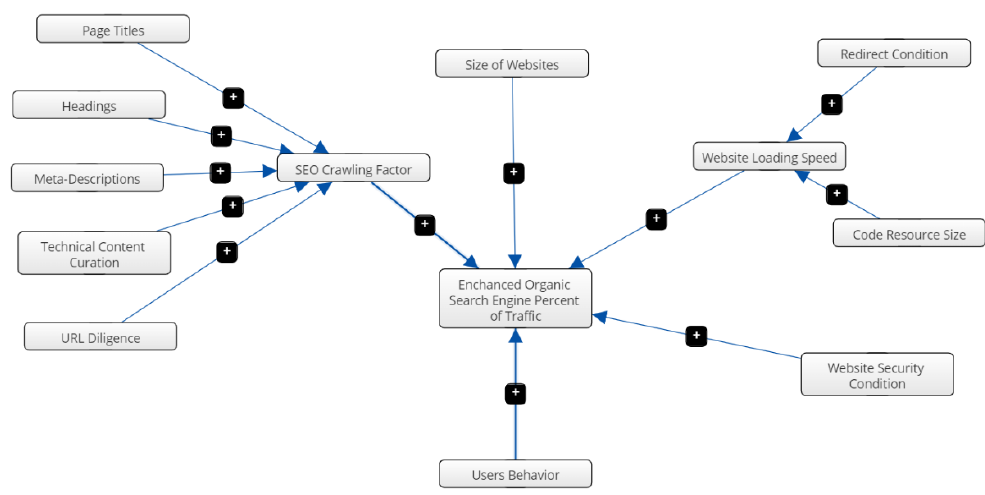
Figure 7. Fuzzy Cognitive Mapping integration as a descriptive, aggregated, and macro-level modeling method for representing the impacts among the examined factors on the percentage increase of Organic Search Engine Traffic.